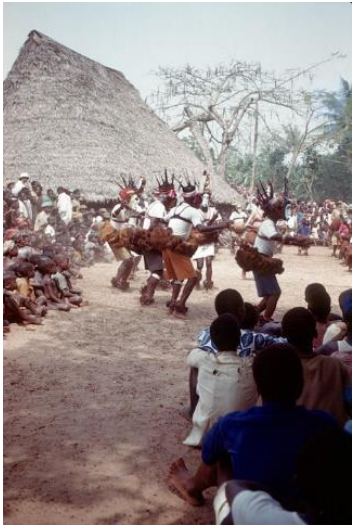
Figure 12 ii. Masquerades Permorming in a Village a square.